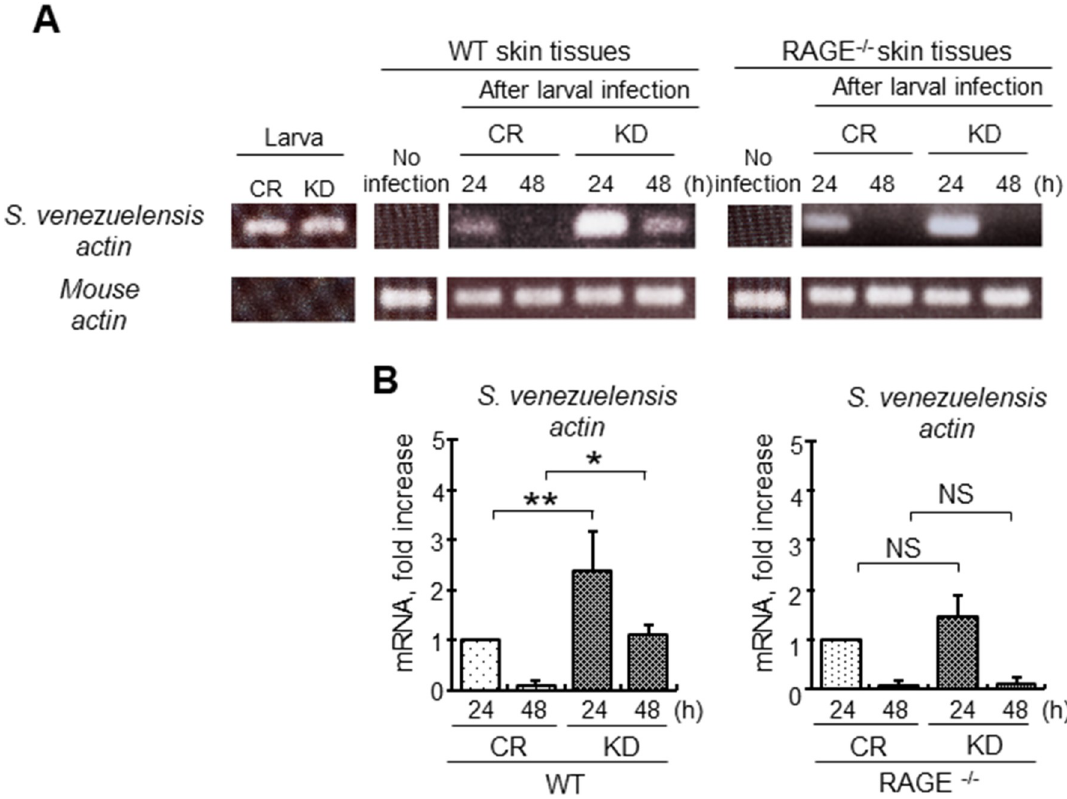
Fig 5. Post-transcriptional silencing of the venestatin gene inhibited migration of S . venezuelensis from skin tissues. (A) Transcripts of S . venezuelensis actin-like protein ( S . venezuelensis actin) in skin tissue of wild-type (WT) or RAGE-null (RAGE -/- ) mice infected with 2,000 LL3s of S . venezuelensis treated with ds luciferase (CR) or ds venestatin (KD) were detected by RT-PCR. Total RNA was extracted from the skin tissues at the larva inoculation site at 24 and 48 h p.i. Na ï ve skin tissues were used as a negative control (no infection). Expression of mouse β -actin (mouse actin) was shown as an internal control. Expression of S . venezuelensis actin in CR or KD LL3s was also assessed. (B) Quantitative RT-PCR analysis of S . venezuelensis actin transcripts. Mouse actin was used to normalize the amount of cDNA, and the expression level in skin inoculated with CR LL3s was set as 1. Data are expressed as means ± SDs for three independent experiments with two technical replicates. � p < 0.01; �� p < 0.001 from the control group. NS, no significant